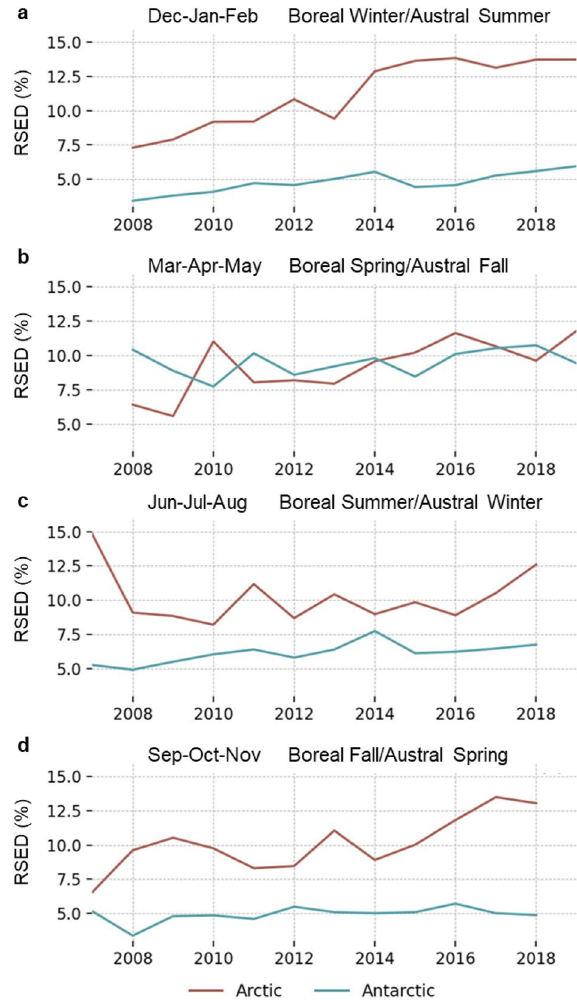
Figure 3. Seasonal RSED from 2007 to 2019 for ( a ) Dec–Jan–Feb, ( b ) Mar–Apr–May, ( c ) Jun–Jul–Aug, and ( d ) Sep–Oct–Nov for the Arctic (red) and Antarctic